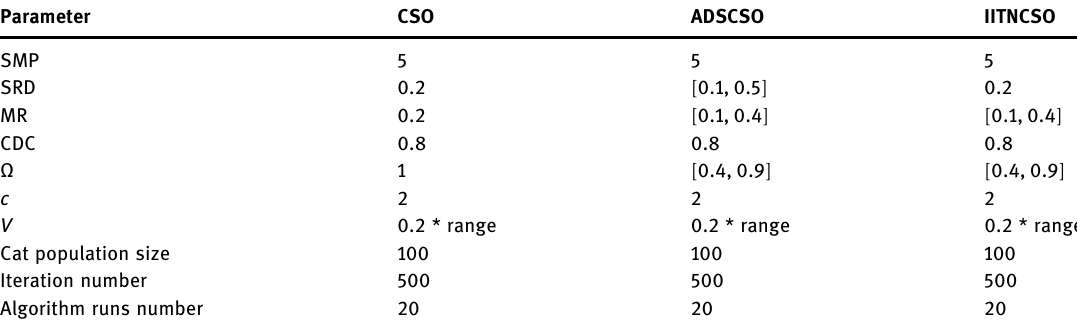
Table 2: Parameter settings Parameter